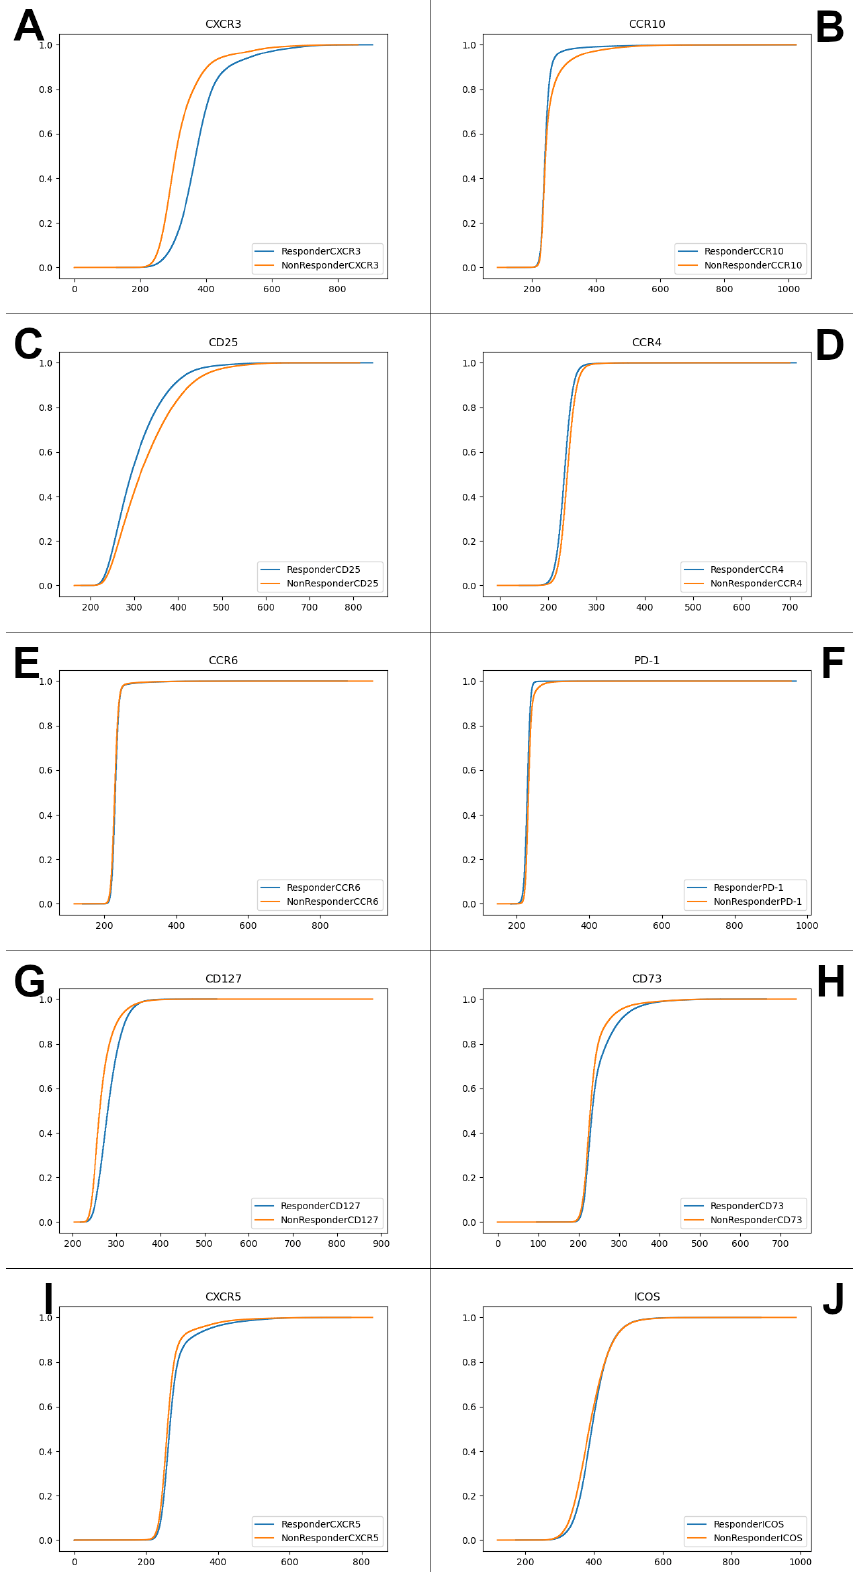
Figure 9. Effective cumulative distribution functions (ECDFs) for CXCR3 and other nine markers’ compensated fluorescent intensities, compared in responders and nonresponders. (Adaptive panel, Naïve CD4+ T cells, day 1). ( A ) CXCR3; ( B ) CCR10; ( C ) CD25; ( D ) CCR4; ( E ) CCR6; ( F ) PD-1; (G) CD127; ( H ) CD73; ( I ) CXCR5; ( J ) ICOS.